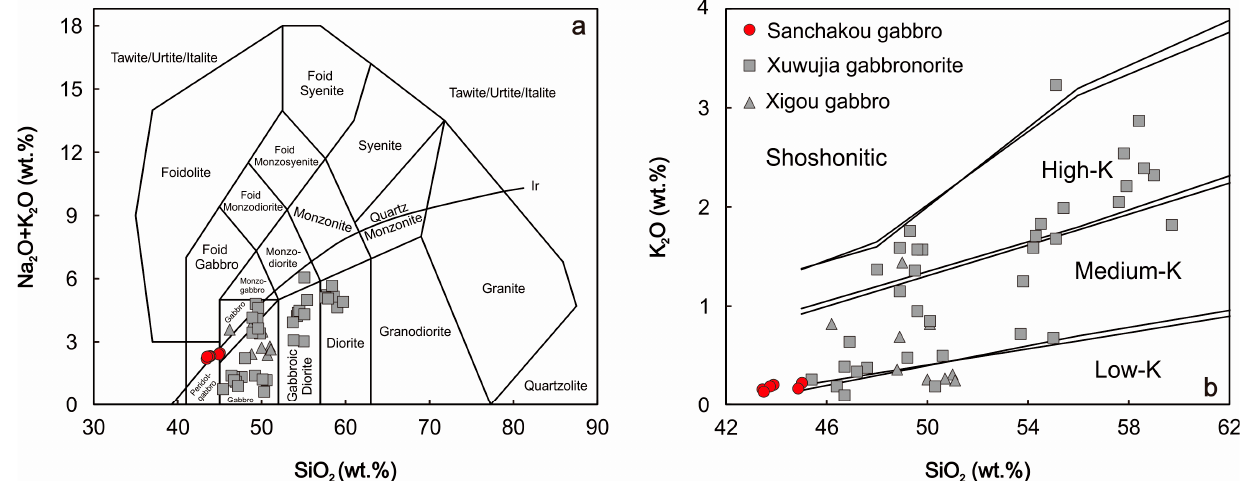
Figure 6. Binary classification diagrams for the Sanchakou gabbros. ( a ) The (Na 2 O + K 2 O) versus SiO 2 diagram [77]; ( b ) The K 2 O versus SiO 2 diagram [78]. The major elemental data of Xuwujia gabbronorites and Xigou gabbros are from [35].